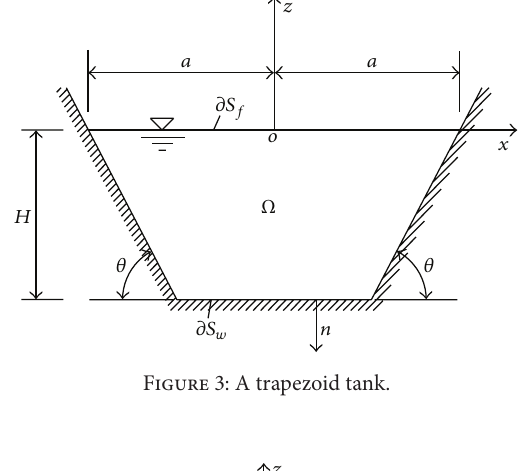
Figure 3: A trapezoid tank.